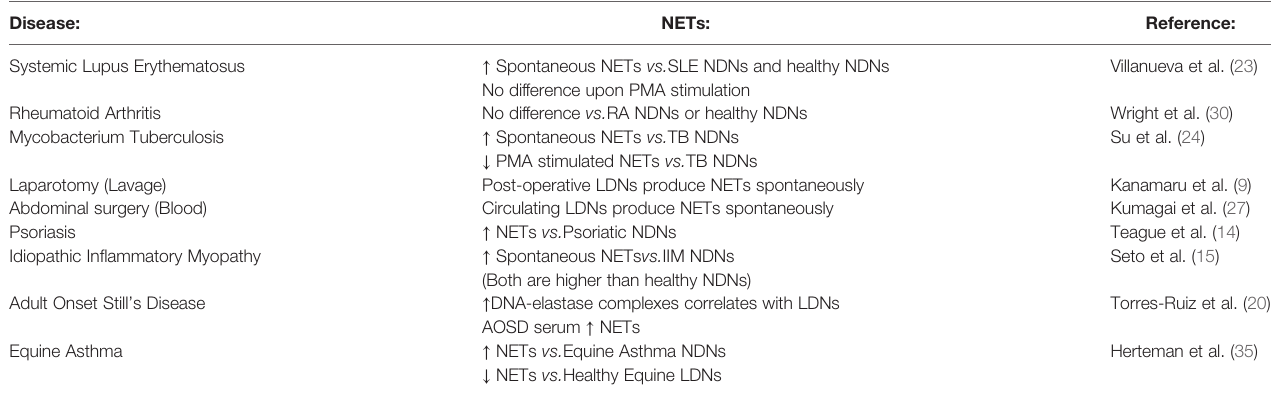
TABLE 2 | Overview of NET formation in LDN